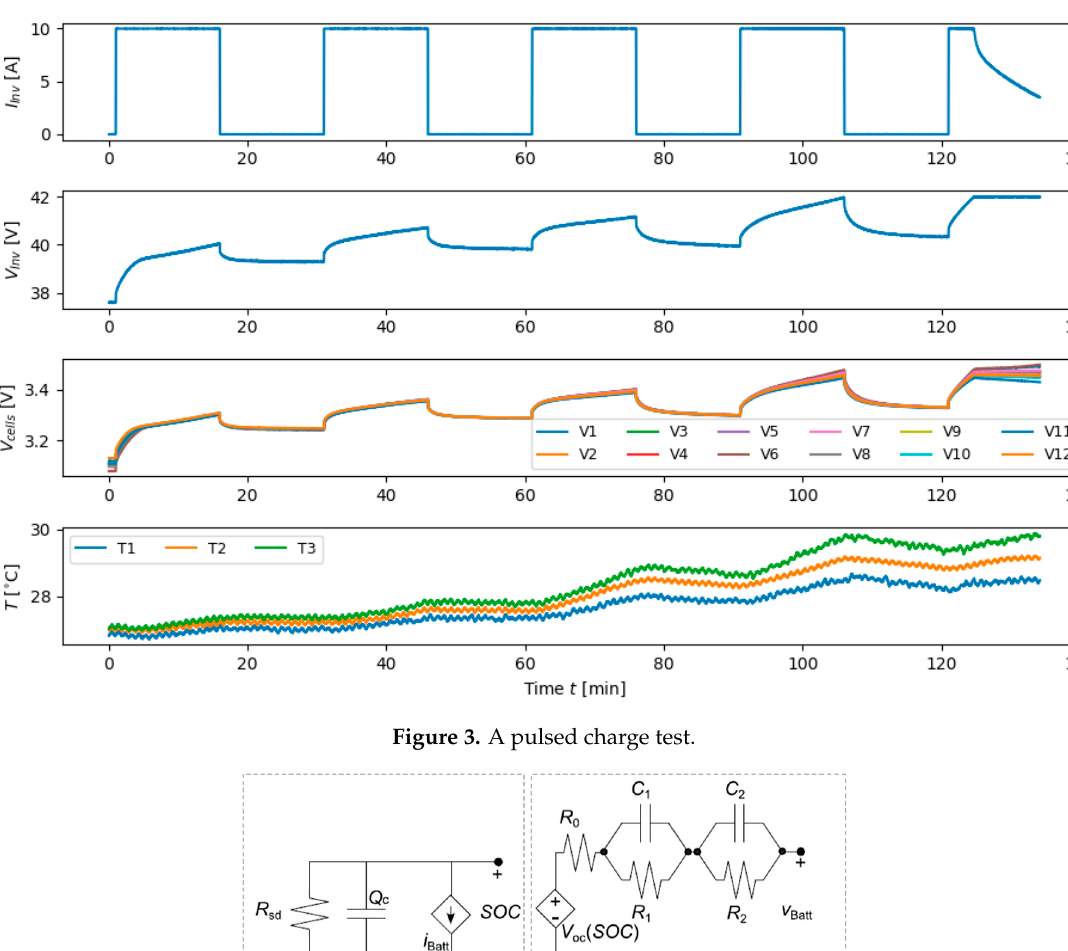
Figure 4. Double-exponential model.